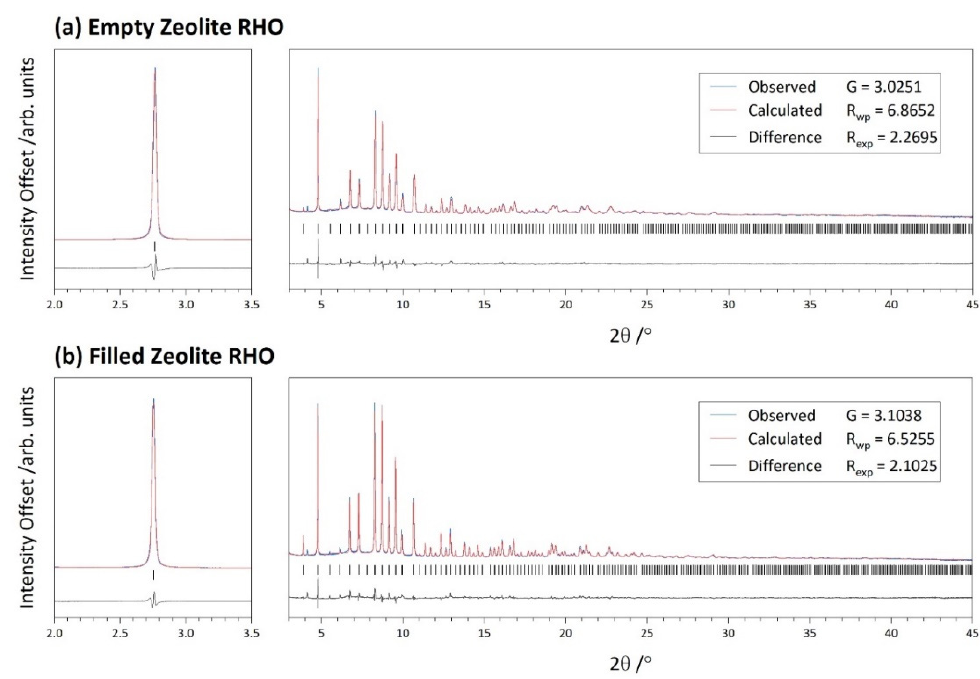
Figure 2. Powder X-ray diffraction patterns for the ( a ) empty and ( b ) filled zeolite RHO samples. The experimental data are shown in blue, the Rietveld fit in red and the difference between the two in grey. Included is the 2 θ = 3.0–45.0 ◦ range ( right ) and an insert of the 2 θ = 2.0–3.5 ◦ range ( left ) covering the (110) Bragg peak. The incident X-ray radiation wavelength was 0.49598 Å. Table 3. Final refined unit cell parameters and crystallographic sites for the empty zeolite RHO sample. ‘Occ.’ refers to the fractional occupancy of the relevant crystallographic site. Error in paren- theses.